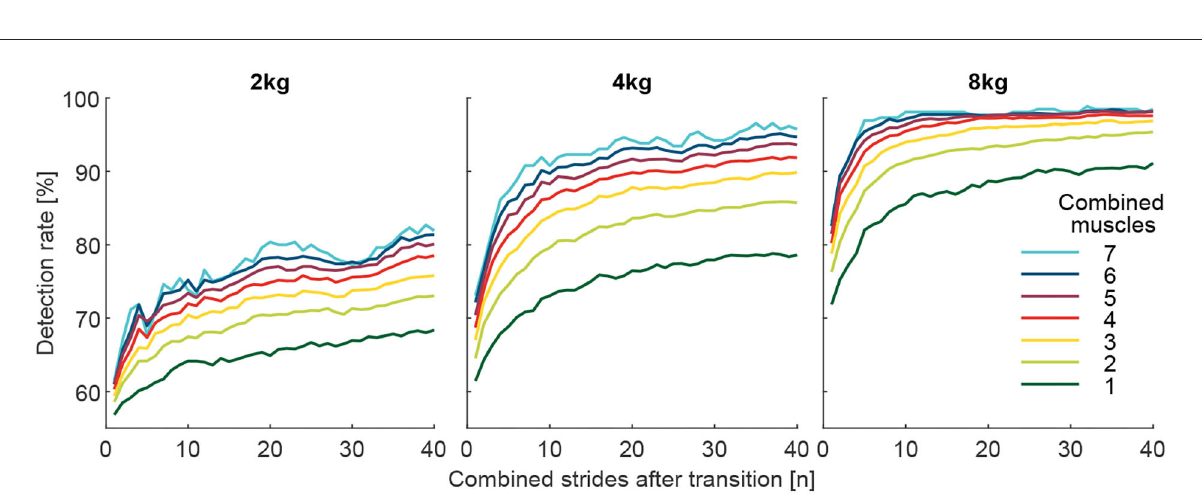
FIGURE8 Detection rate with respect to the number of involved muscles from the 127 possible muscle combinations analyzed. Each graph includes 40 strides in alternating order from the left (20 strides) and right (20 strides) limbs. For example, the dark green curve is the mean of the seven individual muscle analyses, and the light green is the mean of the 21 possible two-muscles combinations. Furthermore, all combinations with 3 (yellow, 35 combinations), 4 (red, 35 combinations), 5 (purple, 21 combinations), 6 (blue, 7 combinations), and 7 (cyan, 1 combinations) involved muscles were